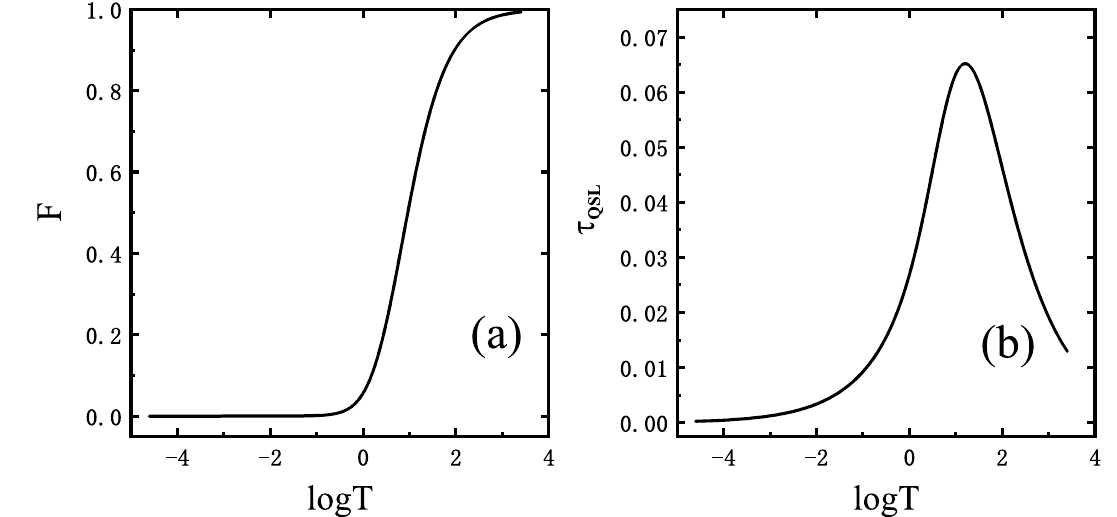
Figure 5. ( a ) The fidelity F and ( b ) the QSL time τ QSL as functions of temperature at a fixed instant t = 5 for a 2 10 4 , with other parameters in both ( a ) and ( b ) are chosen as (cid:31) environment size of N = × 0.05 . Note that there are clearly anomalous phenomena that τ δ =